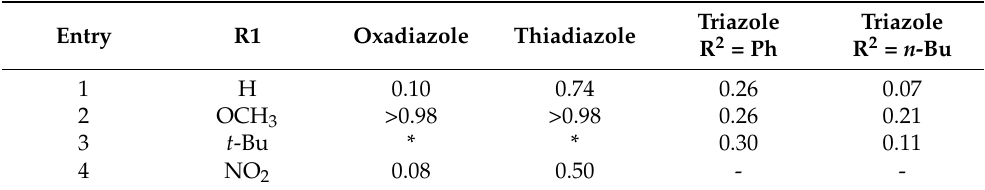
Triazole Triazole R 2 = Ph R 2 = n -Bu